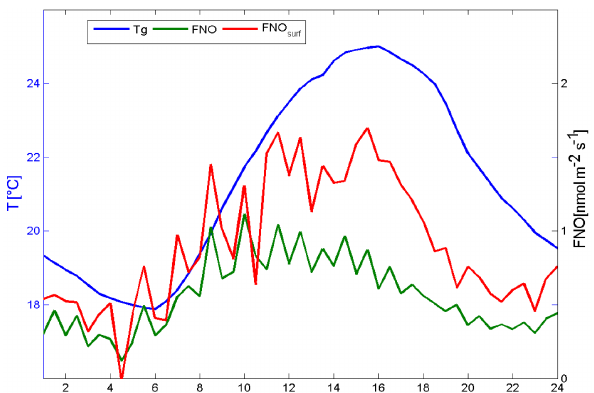
Figure 11. Diurnal cycles of ground temperature, NO flux at mea- surement height and at surface determined by the logarithmic profile in August